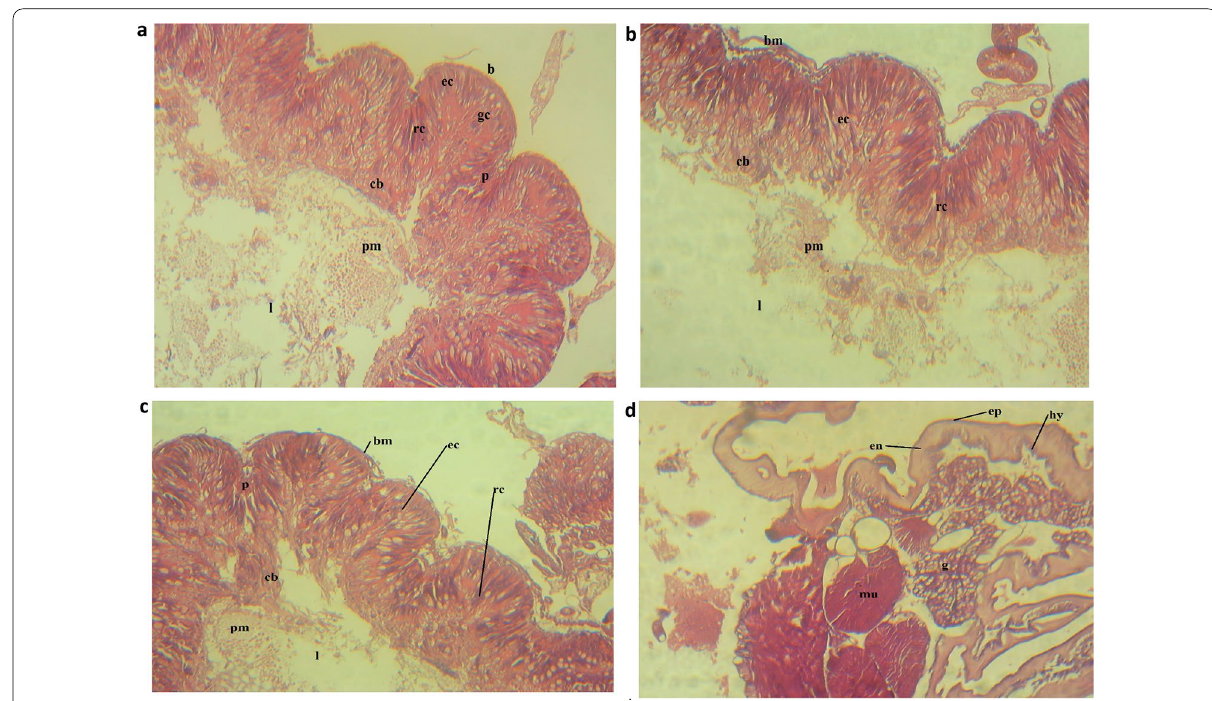
Fig. 3 Photomicrograph of T.S. in the midgut of the late sixth instar larvae of Spodoptera littoralis showing the structure of larval midgut: a the normal, b EMB treatment, c AgNPs treatment, and d EMB AgNPs treatment (b: basement membrane, ec: epithelium cells, rc: regenerative cell, gc: + goblet cell, p: papillary crypt, cb: ciliated border, pm: peritrophic membrane, l: lumen)